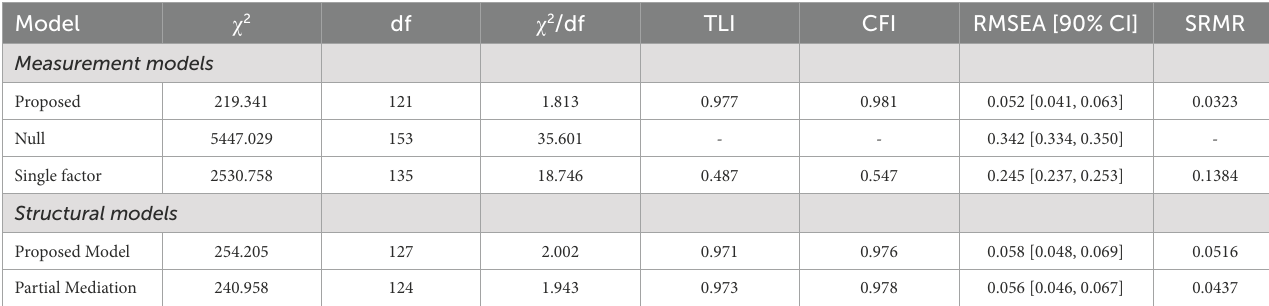
TABLE 1 Fit indices for alternative measurement and structural models.